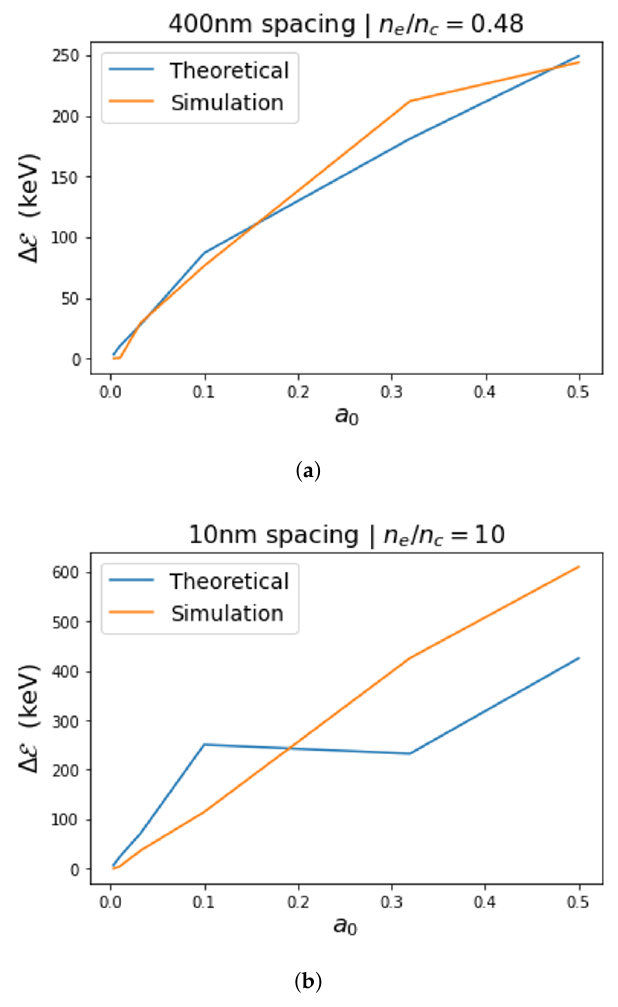
Figure 11. Comparison of maximum electron energies ∆ E with respect to a 0 from simulations to the theoretical scaling law prediction given in (3) for CNT spacing of 400 nm which correlates to n e / n c = 0.48 ( a ) and for 10 nm spacing corresponding to n e / n c = 10.0 ( b ). An interesting idea to consider is that of resonance between the spacing and plasma wavelength of the CNTs. For the present CNT density of 10 22 cm − 3 , the corresponding plasma wavelength is λ p ≈ 334 nm. This case is roughly represented by the red traces in Figure 10. The monotonic decrease in number of extracted electrons with CNT spacing Figure 10b. While the super-critical traces appear to follow different qualitative behavior, the case of a spacing of 300 nm gives the greatest electron energy among the critical and sub-critical traces. These observations suggest a possible resonance between the CNT plasma wavelength and